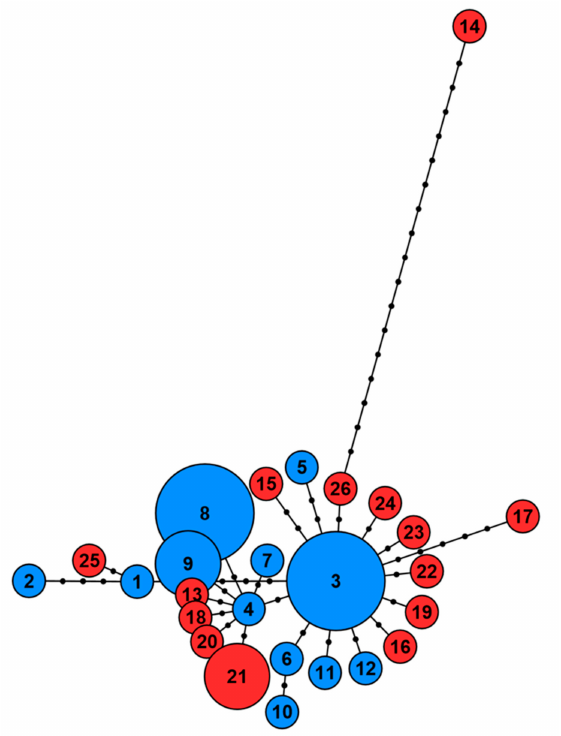
Figure 3. Haplotype network of the mitochondrial DNA control region for 17 captive water voles at Wildwood Trust (blue) and 15 haplotype sequences from natural water vole populations in the South East and East of England